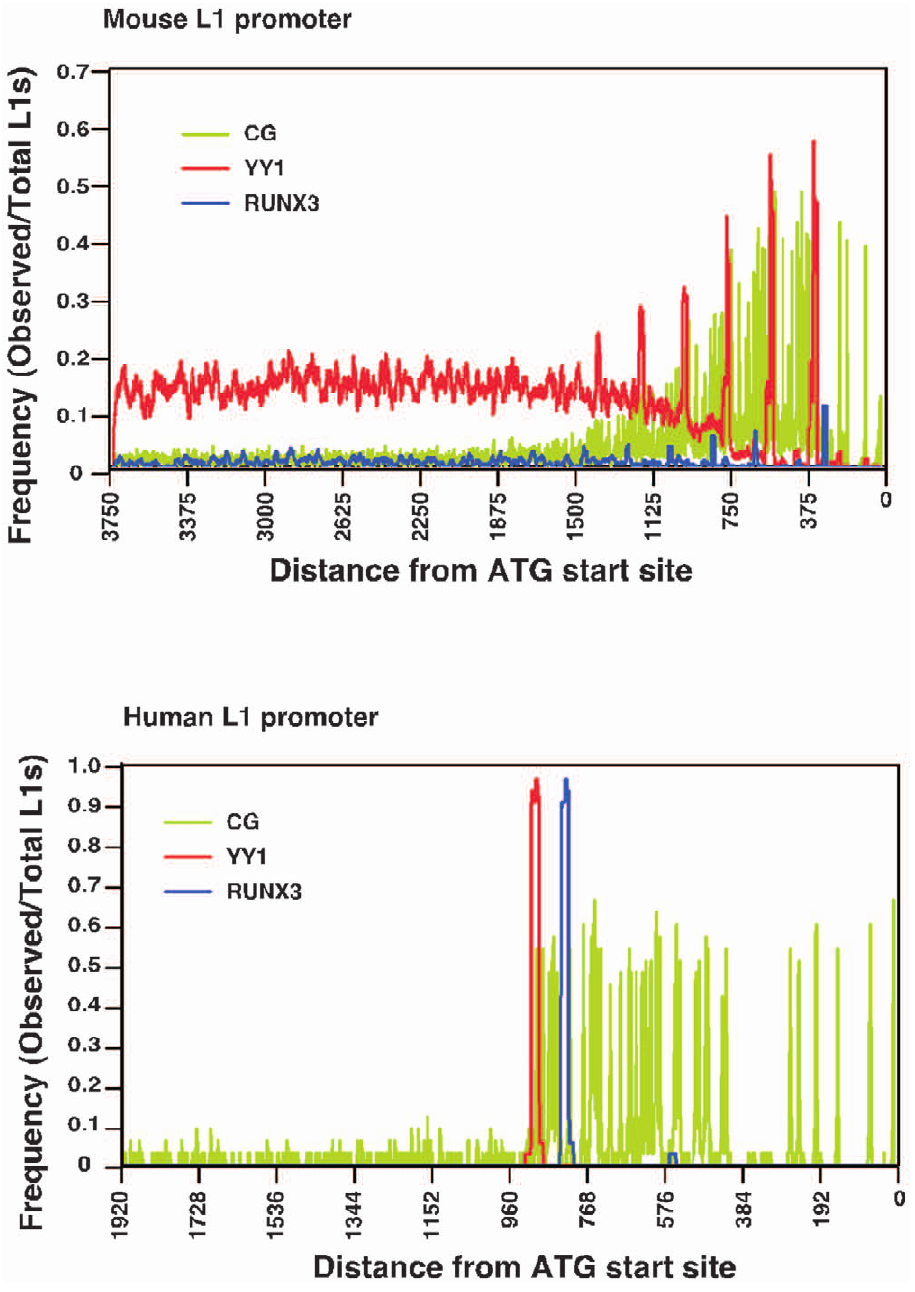
Figure 7. Positional distribution of CpG dinucleotides, the RUNX3 and YY1 motifs relative to start site ATG. The frequency of YY1 and RUNX3 co-occurrence with CpGs was analyzed in the 124 mouse L1 promoters (Top panel) and in the 144 human L1 promoter sequences (Bottom panel).